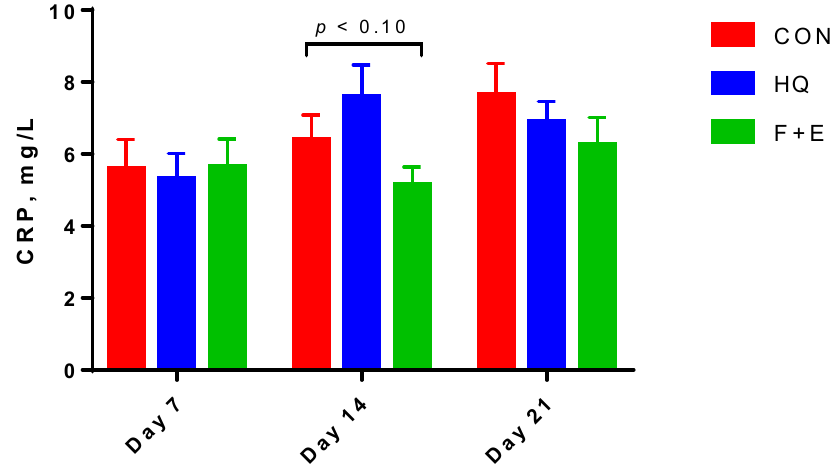
Figure 1. The content of serum C-reactive proteins of lactating sows. The results are presented as mean and SEM. The bars with different small letters mean a significant difference ( p < 0.05) at the same time point, and p < 0.10 means a tendency. CON = control; HQ = high quality; F + E = flavor plus multi-enzymes; CRP = C-reactive protein.